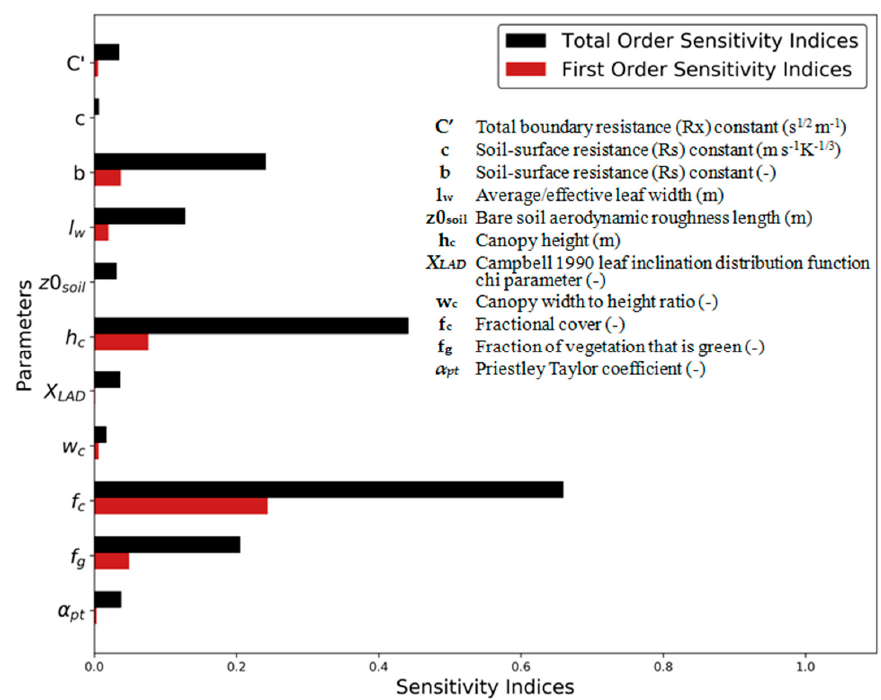
Figure 4. First (S i ) and total (S T ) order SI for the main parameters in TSEB ‐ DF.